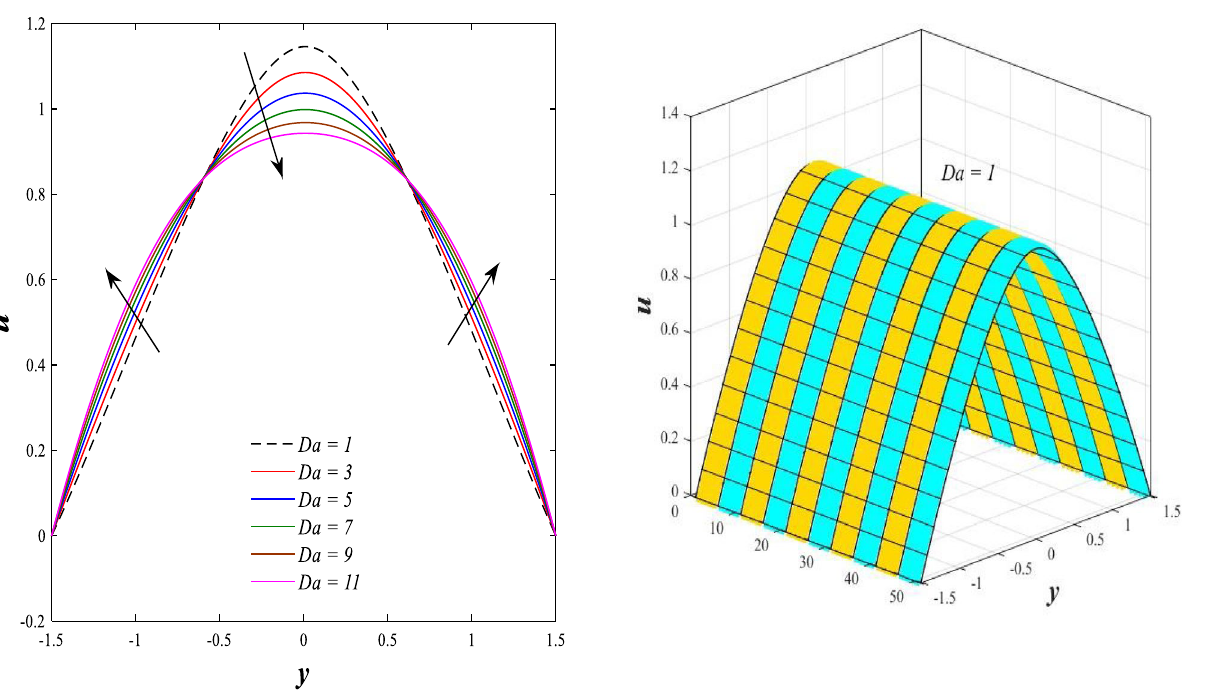
Figure 3. Effect of Darcy number Da on the axial velocity distribution 2D and